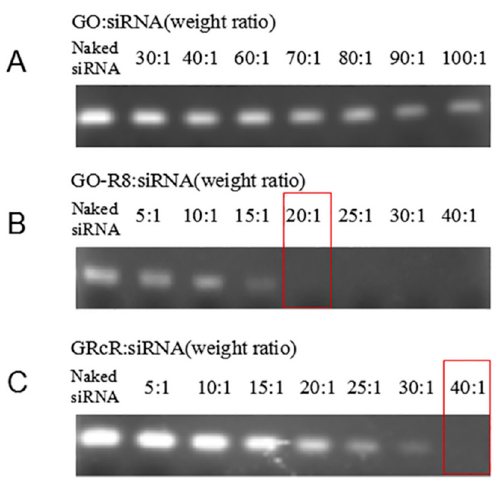
Figure 8. Agarose gel retardation assay of VEGF-siRNA loaded complexed. ( A ) GO/ VEGF-siRNA . ( B ) GO-R8/ VEGF-siRNA . ( C ) GRCR/ VEGF-siRNA . The red frame represents the best proportion.